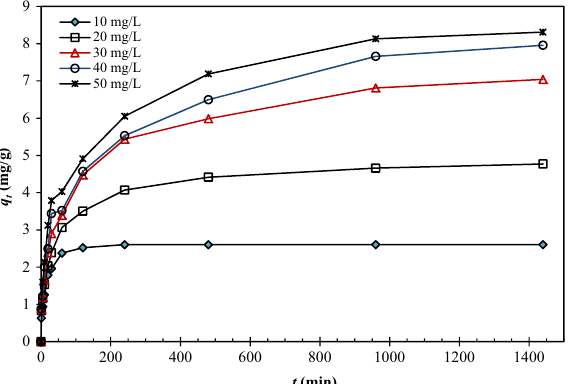
Figure 5. Effect of initial Pb(II) concentrations ( C 0 = 10–50 mg/L) on adsorption capacity of H 2 SO 4 -treated